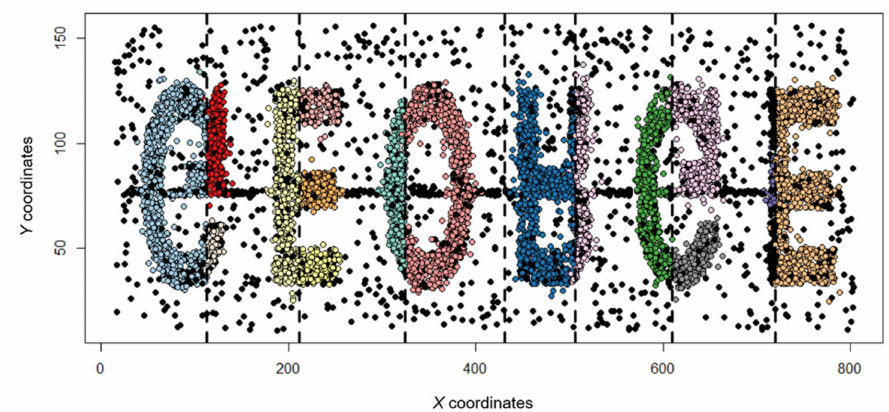
Figure 9. Results of multidimensional spatiotemporal clustering using MDST-DBSCAN.